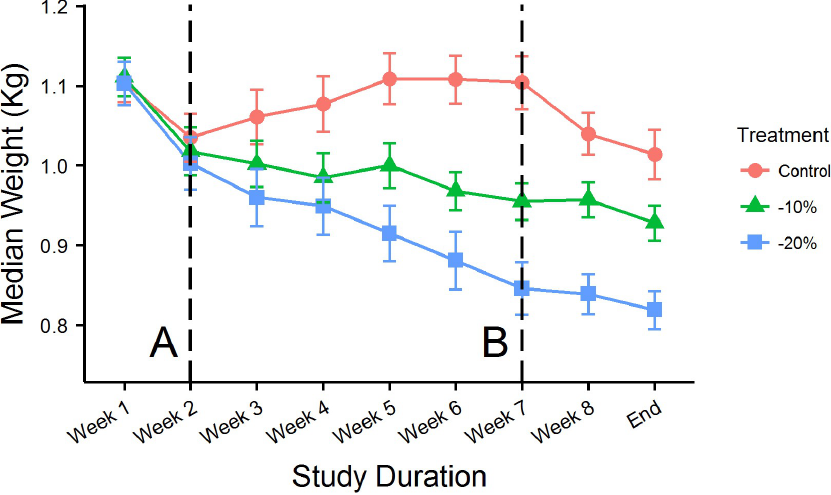
Fig 1. Median Treatment Weights. The median weights of each treatment group every week over the durationof the study. Error bars show +/- one standarderror for each respective day. Line A denotesthe beginningof diet manipulationand Line B denoteswhen the birds were experimentally